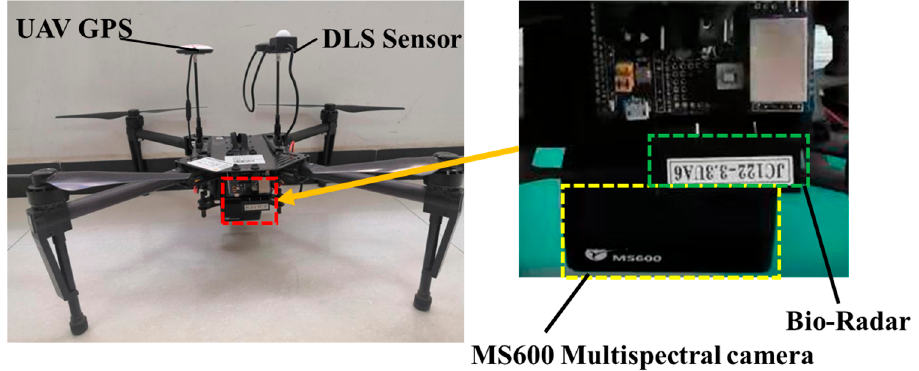
Figure 1. The overall architecture of the bimodal information collection system.